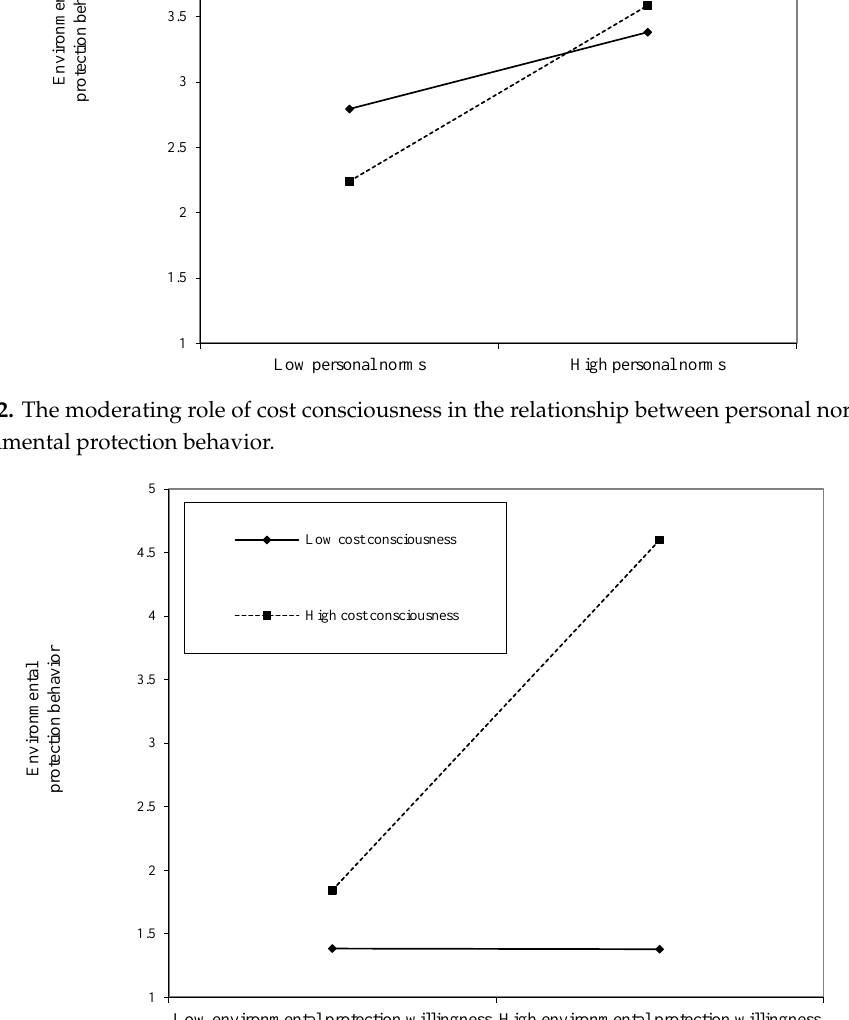
Figure 3. The moderating role of cost consciousness in the relationship between environmental protection willingness and environmental protection behavior.